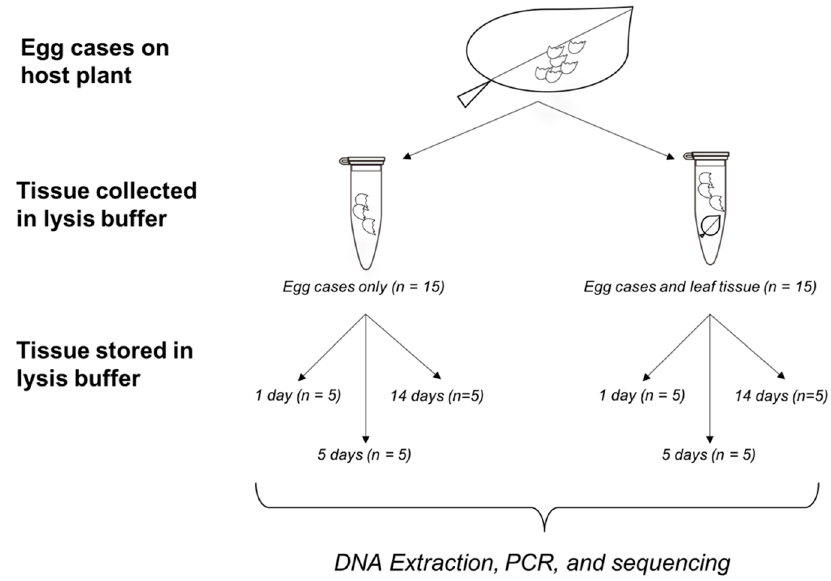
Figure 1. Schematic of proof-of-concept study design.